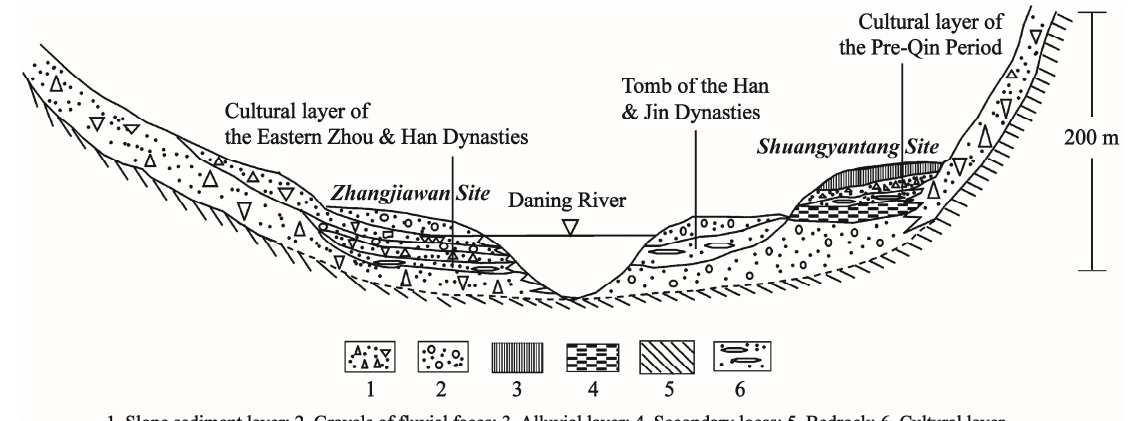
Figure 3. Fluvial geomorphology and strata of the Zhangjiawan and Shuangyantang Sites in the Daning River Valley, Three Gorges area of the Yangtze